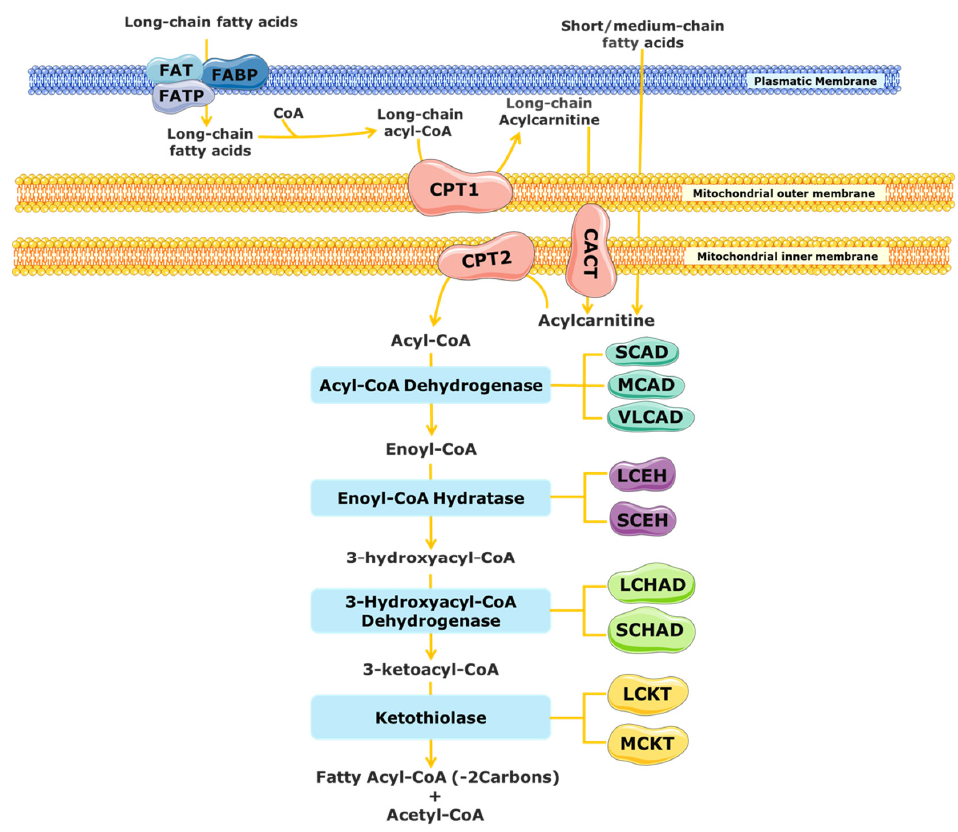
Figure 1. Schematic representation of mitochondrial fatty acid β -oxidation. CACT, carnitine acyl- carnitine translocase; CPT, carnitine palmitoyltransferase; FABS, fatty-acid-binding protein; FAT, fatty acid translocase; FATP, fatty acid transport protein; LCHAD, long-chain 3-hydroxyacyl-CoA dehydrogenase; MCAD, medium-chain acyl-CoA dehydrogenase; SCAD, short-chain acyl-CoA de- hydrogenase; SCHAD, short-chain 3-hydroxyacyl-CoA dehydrogenase; VLCAD, very long chain acyl-CoA dehydrogenases; LCEH, long-chain enoyl-CoA hydratase; SCEH, short-chain enoyl-CoA hydratase; LCKT, long-chain 3-ketoacyl-CoA thiolase; MCKT, medium-chain ketoacyl-CoA thio- lase.